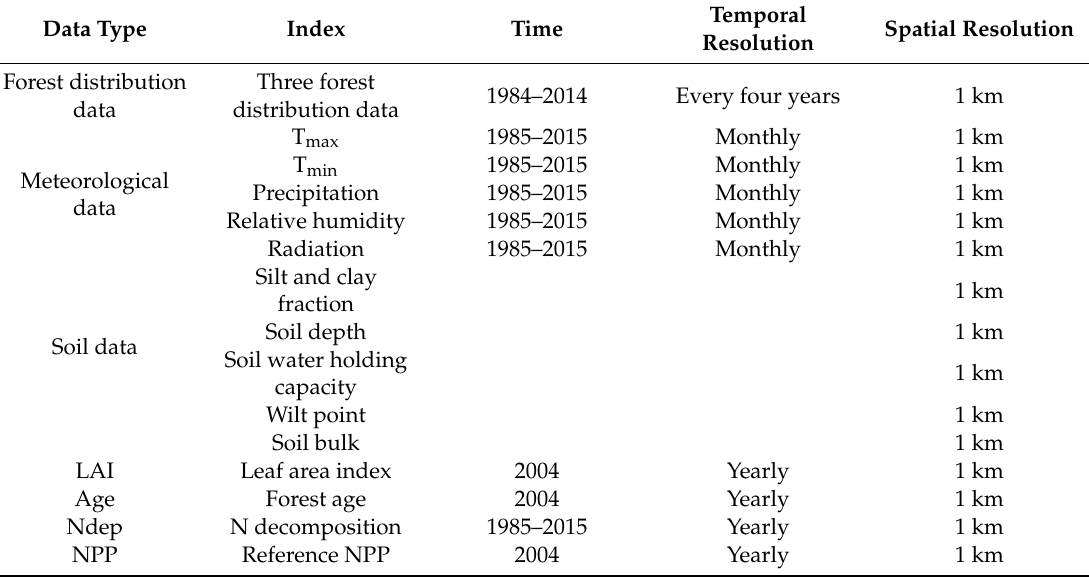
Table 3. Summary of model input data in Zhejiang